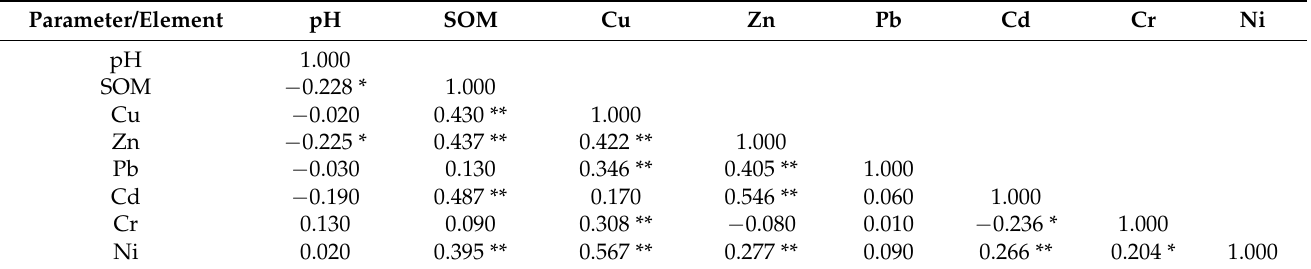
Table 4. Correlation analysis of soil heavy metal content and properties in the study